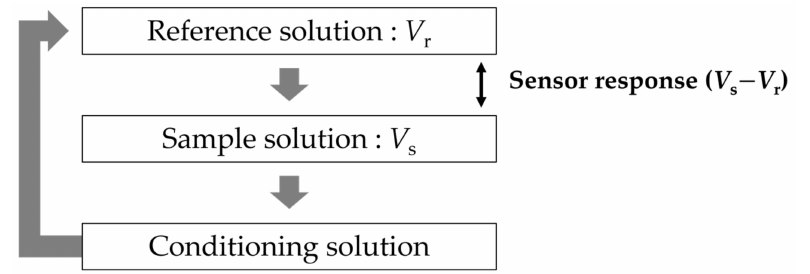
Figure 3. Measurement procedure of taste sensor.